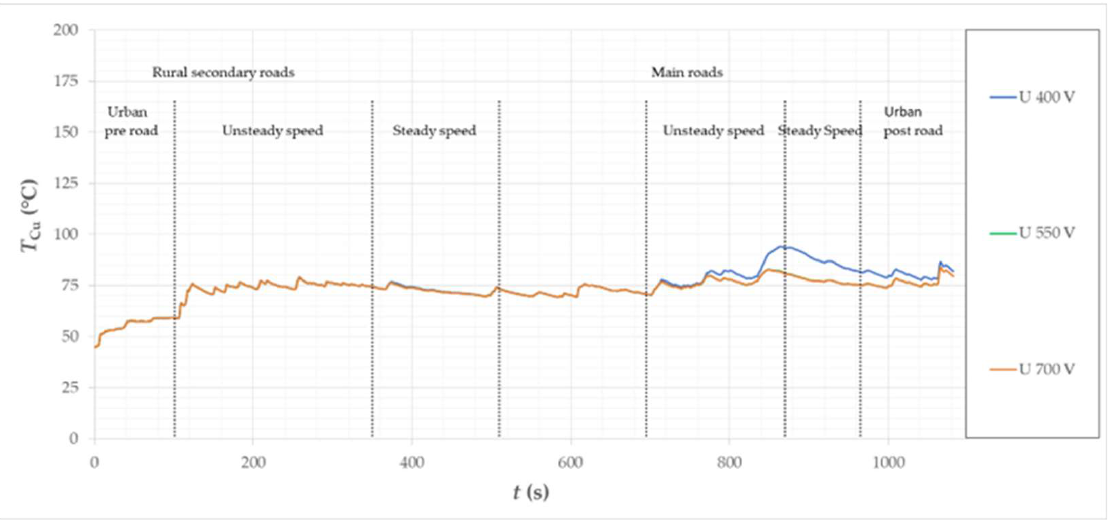
Figure 27. Calculated temperature waveforms in the motor winding (hot spot) for the considered vehicle in the Artemis Road driving cycle .